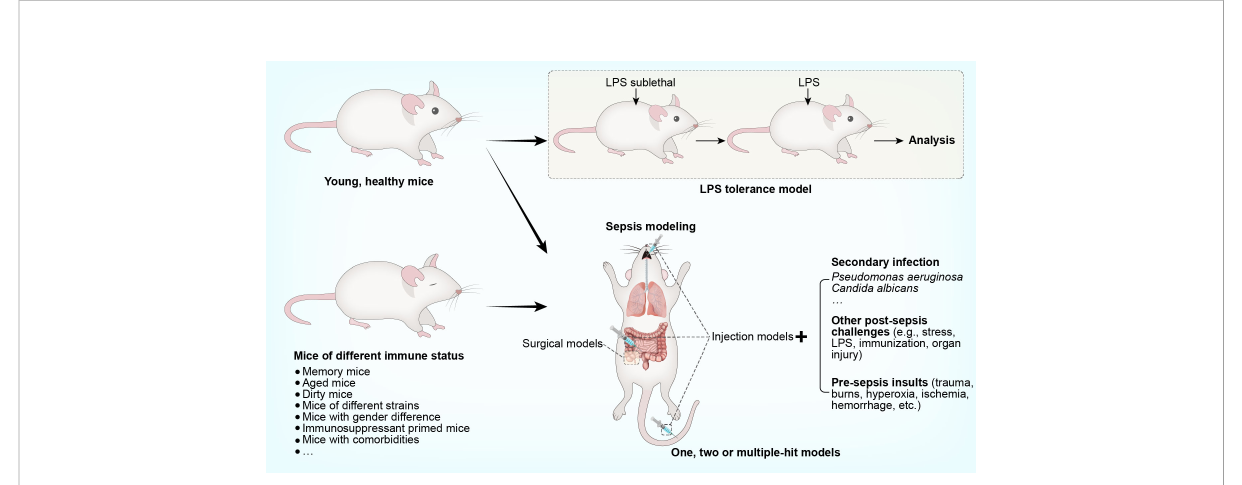
FIGURE 1 Murine models that recapitulate immunosuppression in human